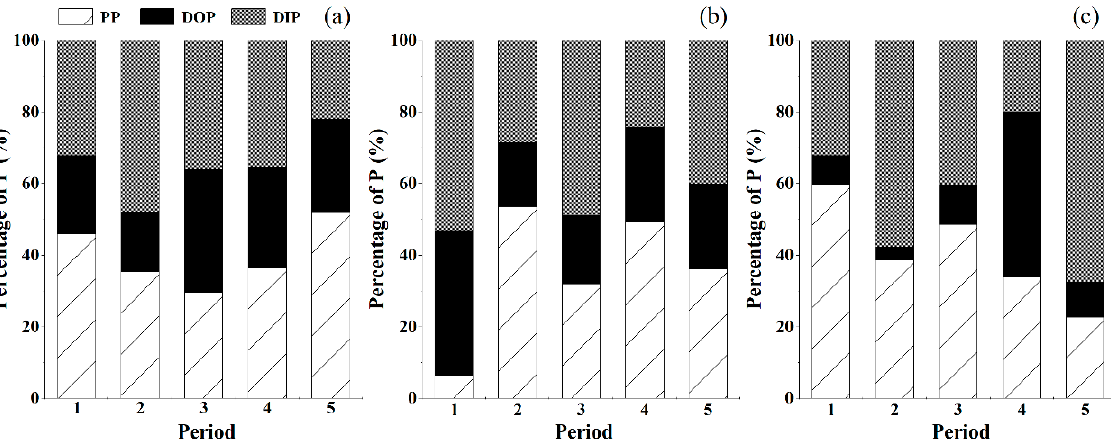
Figure 3. Seasonal variations in leaching losses of DIP ( a ), DOP ( b ), PP ( c ), and TP ( d ). Error bars represent standard deviations. Different lowercase letters on each sample date indicate significant differences among different treatments at p = 0.05, and ns mean no differences among the treatments. Periods 1–5 indicate the same as those in Figure 2.